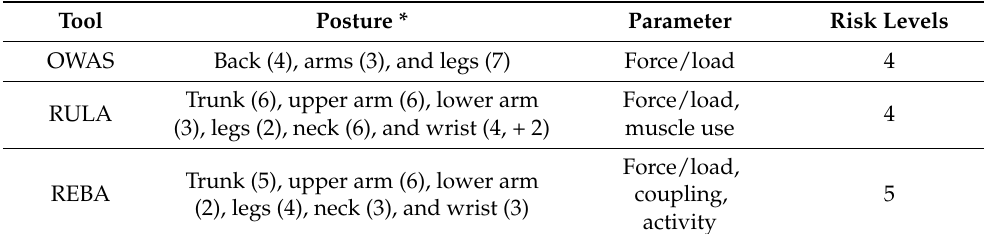
Table 1. Classification criteria for major working-posture-assessment tools. Tool Posture * Parameter Risk Levels